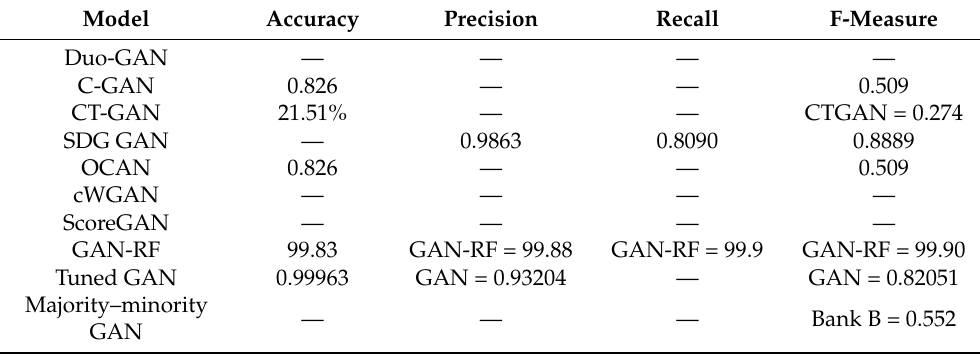
Table 1. Comparison table of GAN-based methods. This tabular representation presents different studies conducted by researchers in more recent times to generate synthetic data. It provides a detailed tabular presentation of different datasets and methods, their merits and demerits, as well as the Accuracy, Precession, Recall and F-1 scores of multiple studies to provide a detailed description of their key